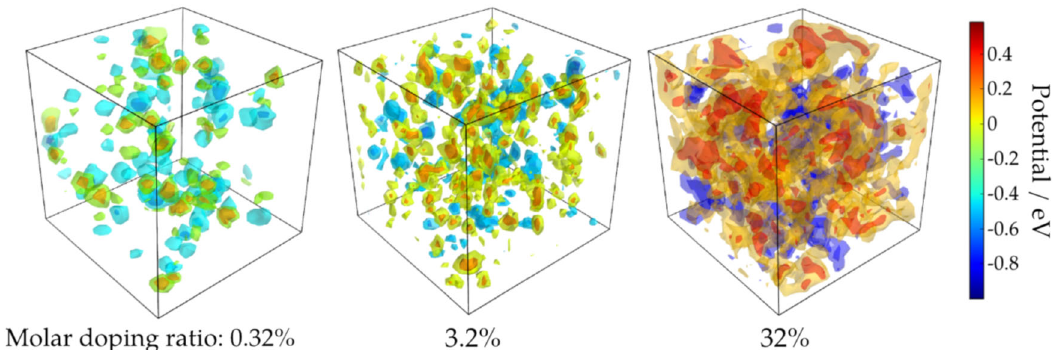
Fig. 2 3D contour plots of the energy landscape for F 8 ZnPc for increasing doping concentration. Blue/orange structures are regions with negative/ positive potential for charge carriers, respectively (exemplary colorbar for 32%). See Supplementary Note 1 for parameter information. Upon increasing the concentration, there is a transition from rather isolated potential hills and valleys to large, fl uctuating structures. Thus, at low concentrations, the spatial correlations of the site energies are stronger than at high concentrations. This transition is accompanied by a transition in the critical charge transport paths, i.e. from long-range hopping between the separated wells to hopping on all length scales through the fl uctuating landscape (see Fig.